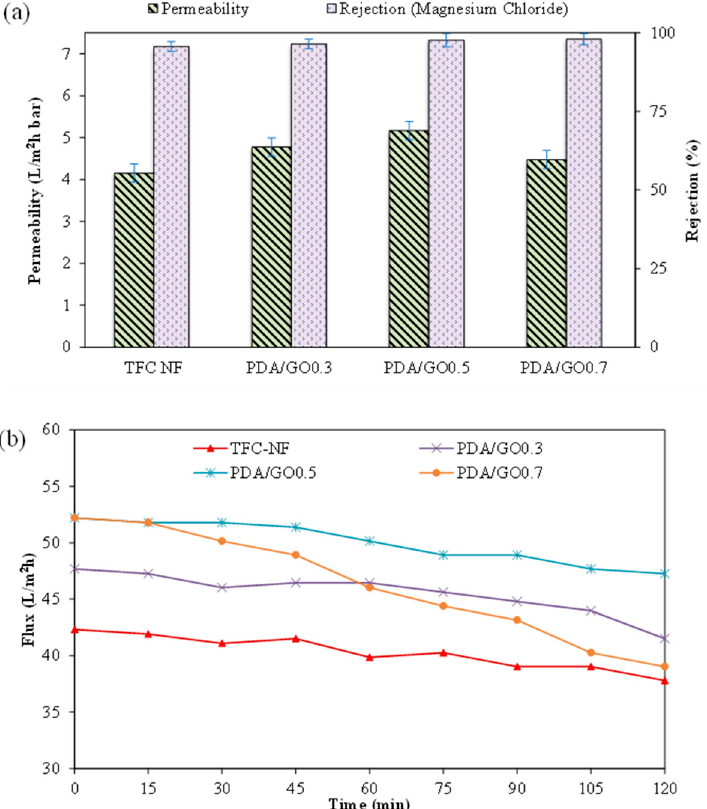
Figure 8. Performance of TFC membrane (made of 1:5 PAN/PPSU substrate) with and without PDA/GO coating layer in terms of ( a ) permeability and MgCl 2 rejection (Operation mode: pressurized filtration; feed solution: 1000 ppm salt solution; operating pressure: 10 bar; temperature: 24 °C (+1)), and ( b ) water flux profile as a function of AT-POME filtration time (Operation mode: pressurized filtration; feed solution: AT-POME; operating pressure: 10 bar; temperature: 24 °C (+1)).